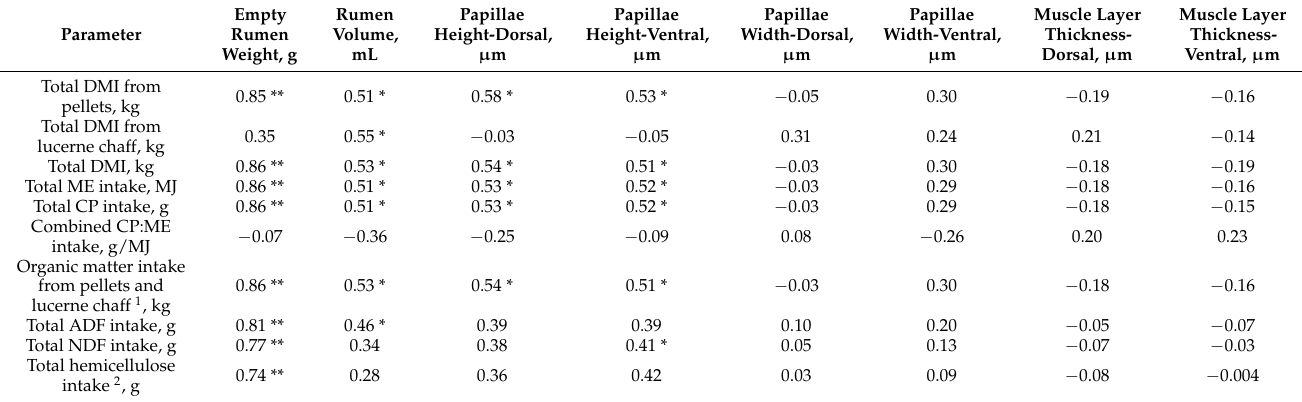
Table 6. Pearson correlation coefficients of dietary factors and rumen physical development parameters of artificially reared lambs exposed to three rearing treatments (DMI, dry matter intake; ME, metabolisable energy; CP, crude protein; ADF, acid detergent fibre; NDF, neutral detergent